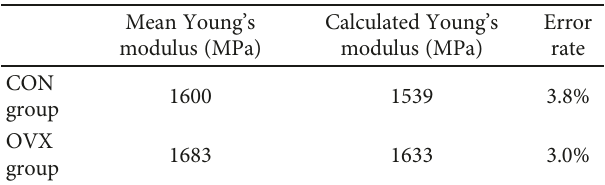
Table 3: Comparison of Young ’ s